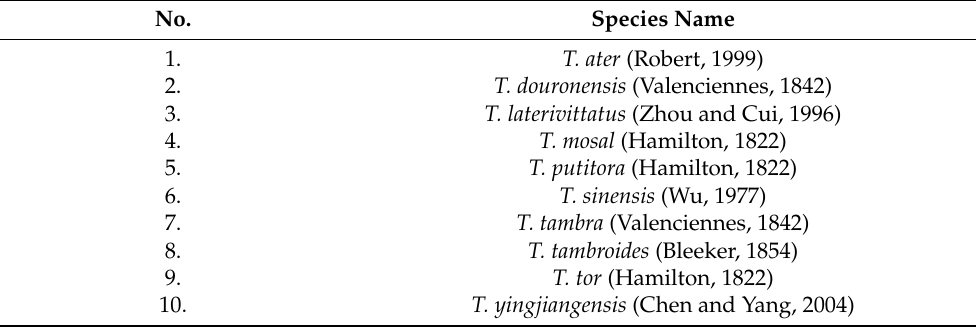
Table 4. Suggested valid Tor species in SE Asian